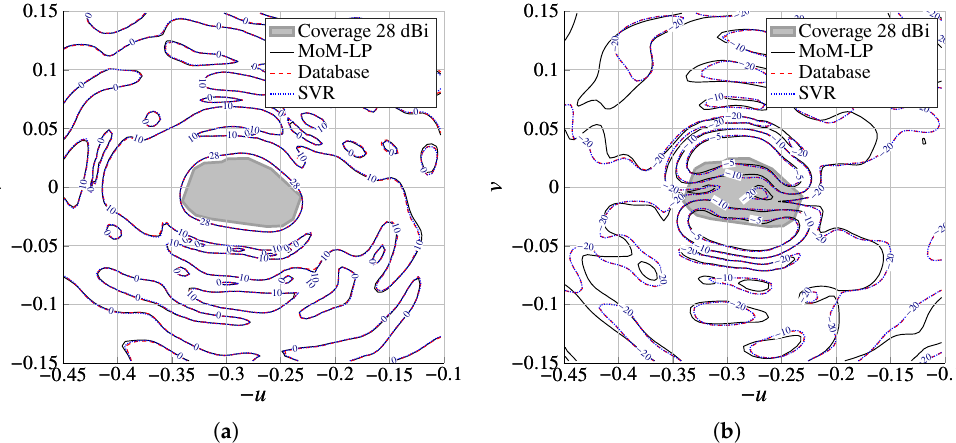
Figure 8. Comparison of the simulations with MoM-LP, database and SVR for the ( a ) copolar and ( b ) crosspolar patterns for polarization X of a reflectarray with European coverage using a layout obtained with the